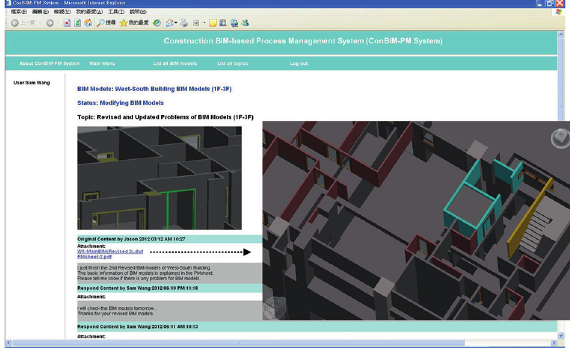
Fig. 4. BIM PM tracking and sharing in the ConBIM-PM system